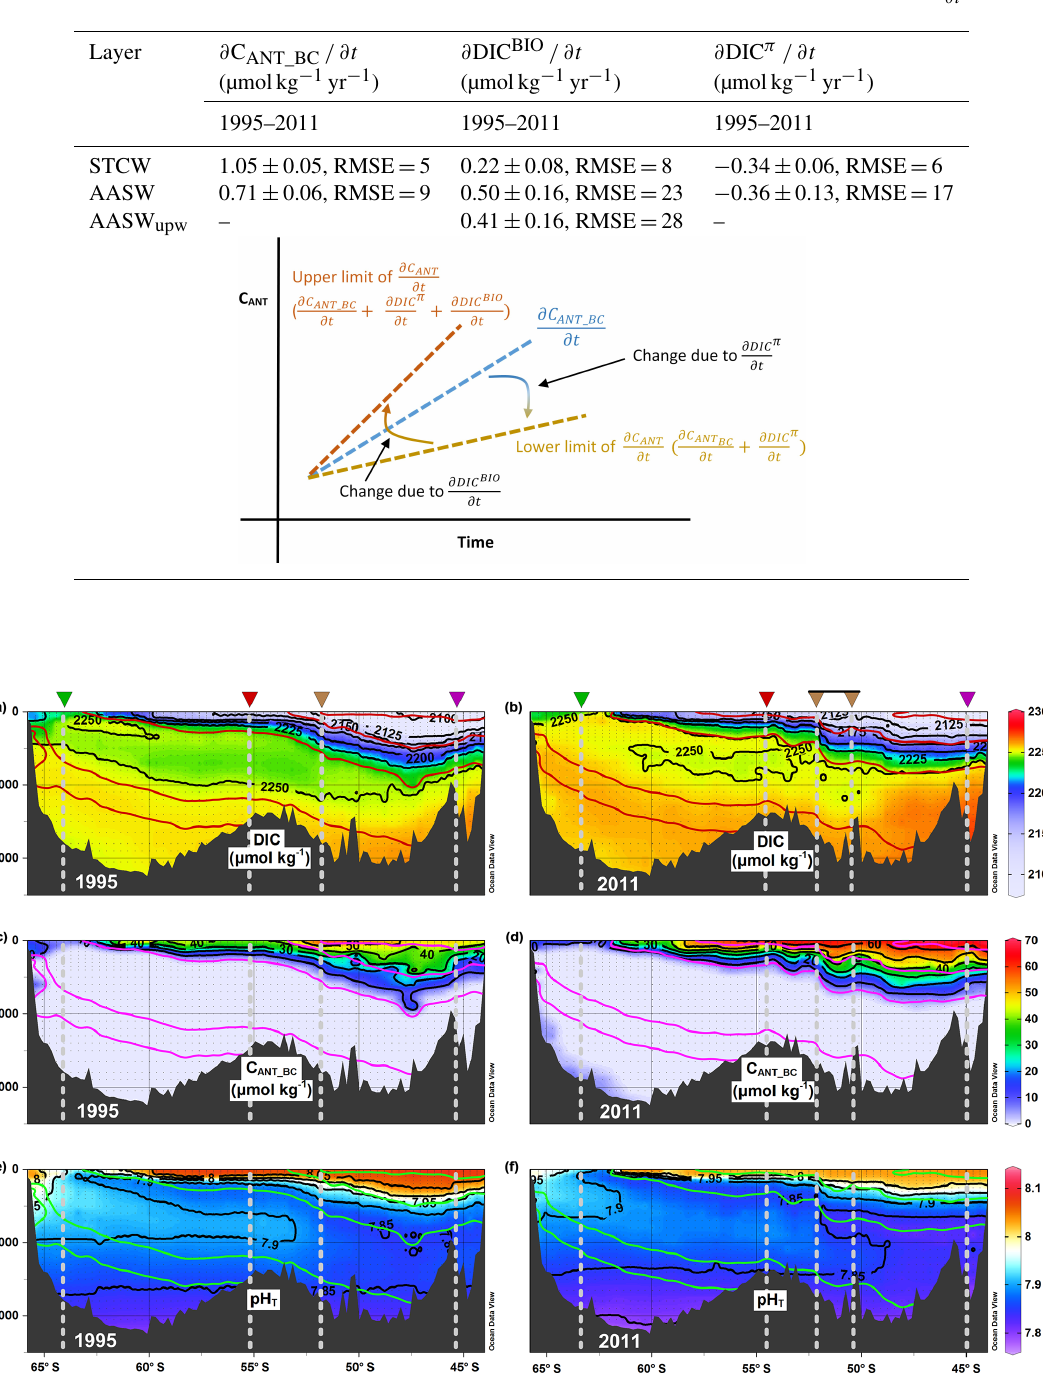
Table 5. Trends of anthropogenic carbon from estimates of the back-calculation method and of the terms DIC BIO and DIC π (see Sect. 3.2 of the text). RMSE = root mean square error. Bottom: schematic of the estimation of the upper and lower limits of ∂ C ANT